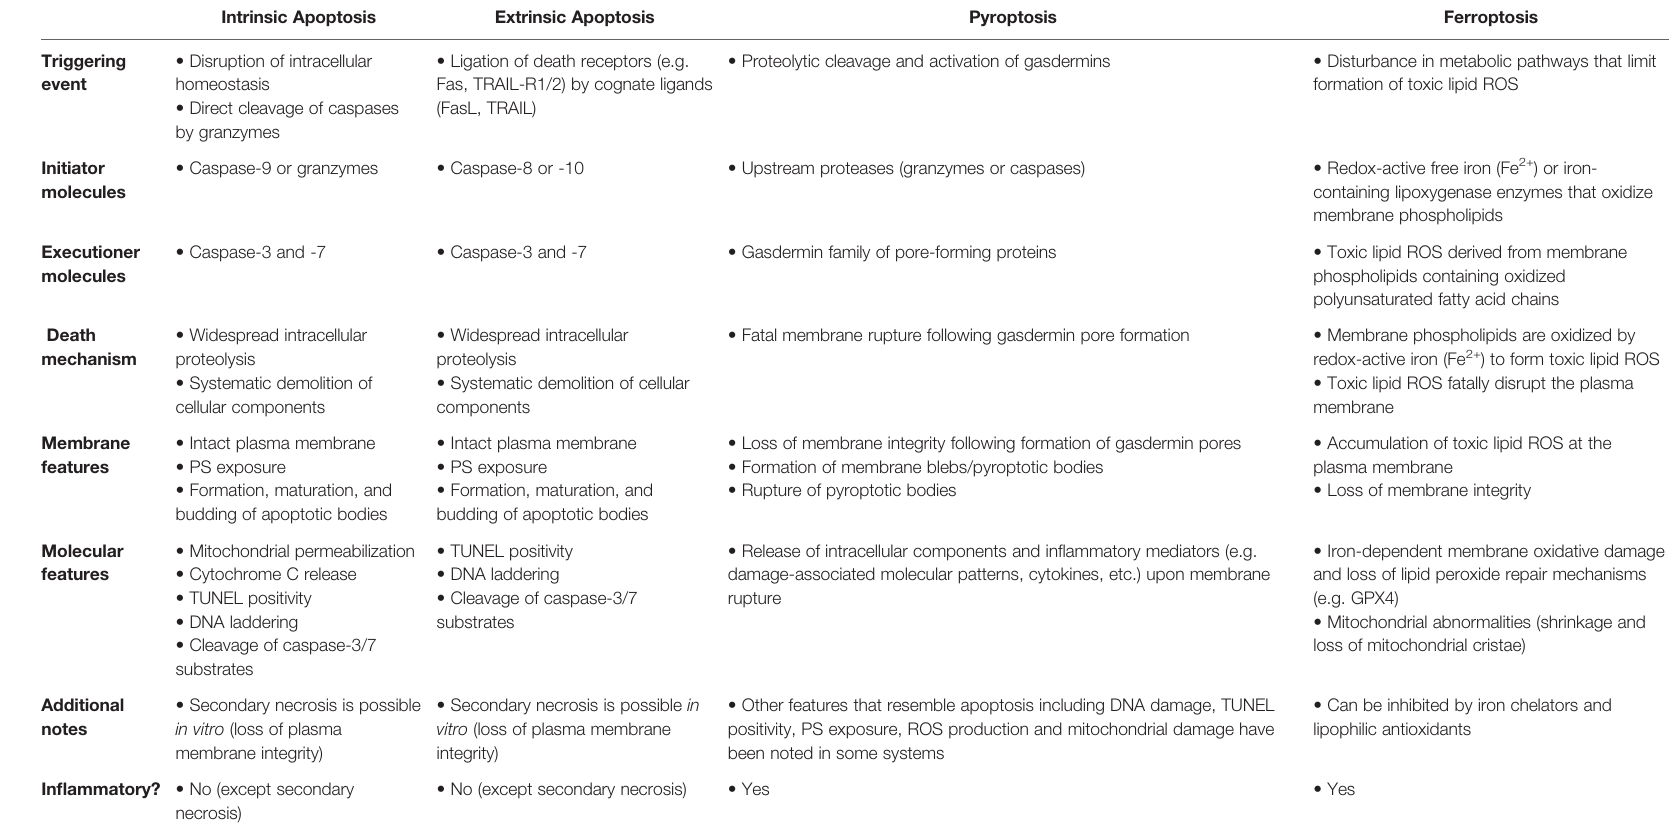
TABLE 1 | Molecular and morphological features of different regulated cell death modalities in the context of CTL